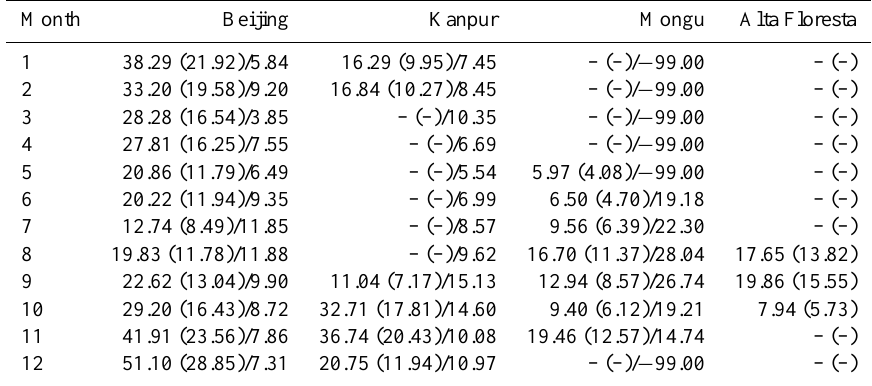
Table 3. Comparison of monthly mean OC (mgm − 2 ) from Oslo CTM and those retrieved from AERONET imaginary index. First are the AERONET-based OC concentrations (fine mode only in parenthesis), the model-based OC concentrations after the